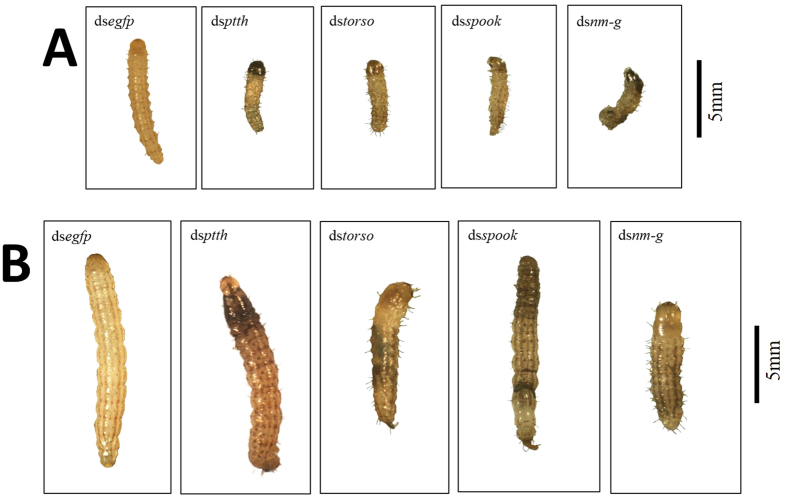
Developmental defects in RNAi-treated individuals.The dead larvae in each RNAi-treated group showing abnormal phenotypes during metamorphosis. The group fed with dsegfp was used as the negative control. (A) represents metamorphosis from 1st to 2nd instar larvae. (B) represents metamorphosis from 2nd to 3rd instar larvae.